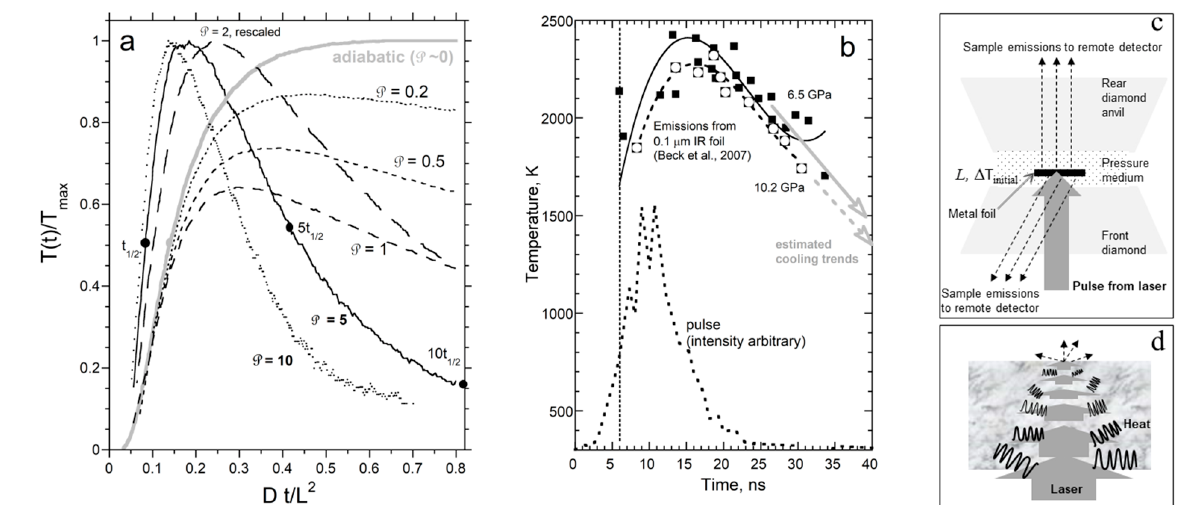
Figure 2. Cowan’s model for LFA contrasted with DAC laser heating experiments: ( a ) Theoretical dimensionless cooling curves that assume small temperature changes and a narrow laser pulse (spike at Dt / L 2 = 0) as in LFA experiments. Small radiative losses ( ℘ < 1) are calculated using Equation (16) without modification, whereas T - t curves for large losses ( ℘ = 2, 5, or 10) from (16) are rescaled with maximum temperature set near unity. Scaling provides a visual curve more like LFA data (Figure 1) and better shows the downshifting of the halftime. Dots = t ½ and its multiples. ( b ) Temperatures (squares) ascertained by Beck et al. [30] from fitting emissions from laser heating the rear side of a 0.1 μ m thick foil of iridium sandwiched between thin MgO slices in a DAC. Data were digitized and a polynomial fit was made to emissions processed at two different pressures. Unlike LFA, the laser serves as an unsteady furnace that provides a large surge in T, rather than adding an increment of heat. ( c ) Schematic of diamond anvil experiments on uncoated metal films. ( d ) Schematic of heat generated as the laser pulse penetrates and attenuates as it crosses an uncoated sample. Part ( b ) is modified after Beck et al. [30] with permission from AIP.